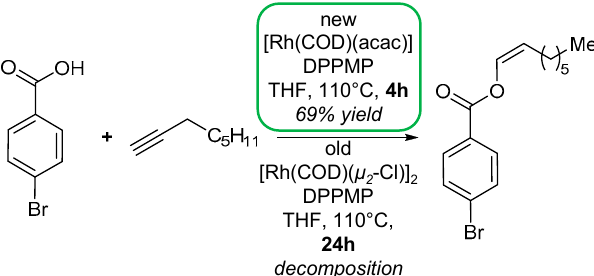
Figure 1. Molecular structure of [Rh(DPPMP) 2 ][Rh(COD)Cl 2 ], left, molecular structure of [Rh(DPPMP) 2 ][H(benzoate) 2 ] and [Rh(COD)( µ 2 -benzoate)] 2 , right. Hydrogen atoms (except H (benzoate) 2 ) are omitted for clarity [49].